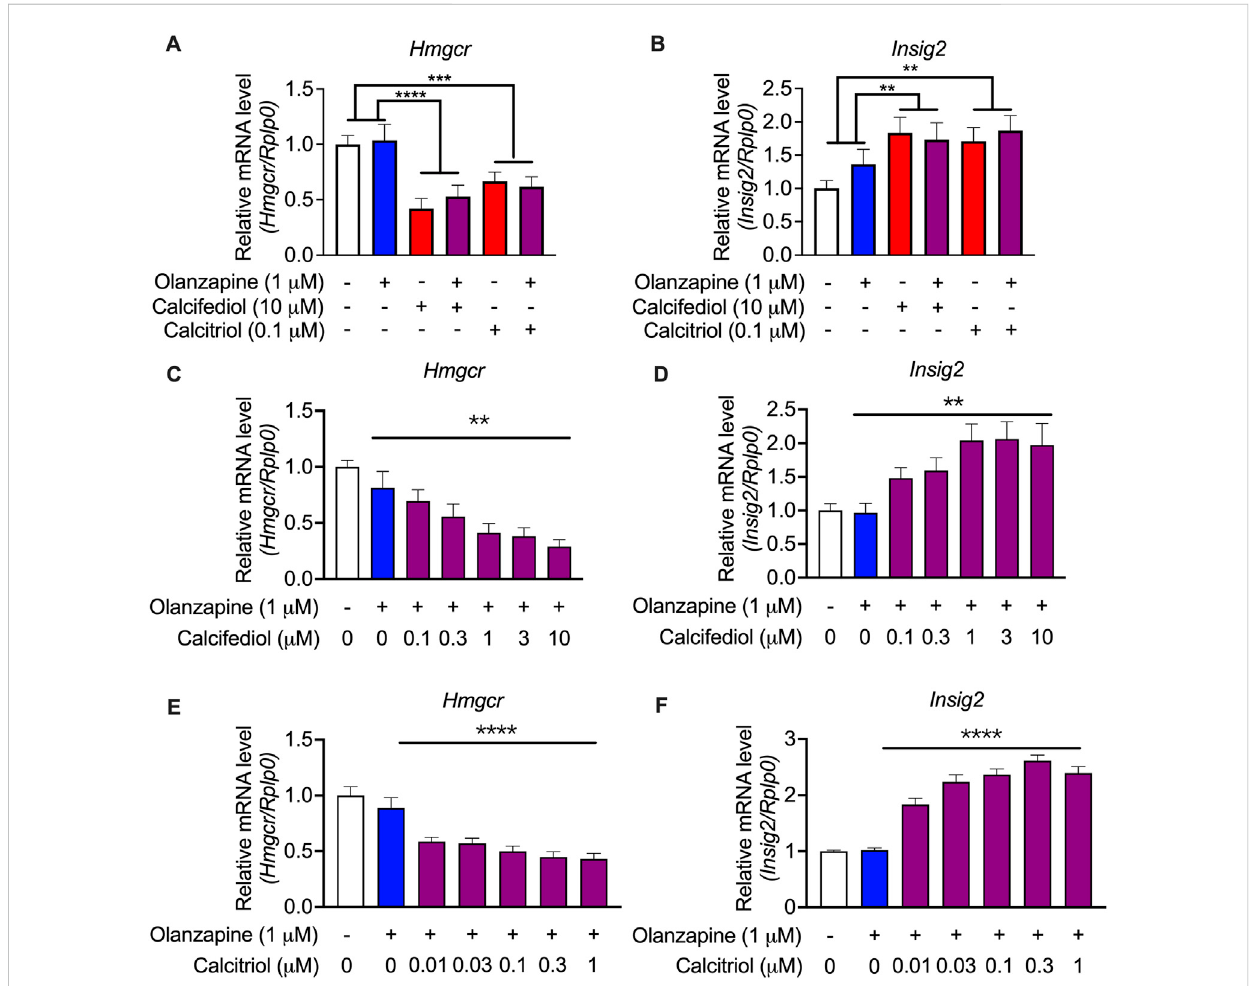
FIGURE 6 ValidationbyquantitativeRT-PCRresultsshowingtheexpressionofcholesterolbiosynthesis-associatedgenesintheculturedC2C12cellline. (A) 3- hydroxy-3-methylglutaryl-CoA reductase ( Hmgcr ) and (B) Insulin-induced gene 2 ( Insig2 ) were validated in the same treating condition as that in the RNA-seqexperiments( n =12).Resultswerenormalizedtoribosomalprotein,large,P0( Rplp0 ). (C) Hmgcr and (D) Insig2 werevalidatedincalcifediolwith gradient-changed concentrations increasing from 0 to 10 μ M ( n = 8 – 9). (E) Hmgcr and (F) Insig2 were validated in calcitriol with gradient-changed concentrationsincreasingfrom0.01 μ Mto 1 μ M.Data are shownas means± SEM( n =9).** p < 0.01, **** p < 0.0001.Thecomparisonsofolanzapine and vitamin D in fl uences were compared by two-way analysis of variance (ANOVA). The validation of the dose-dependent effects of calcifediol and calcitriol were compared by one-way